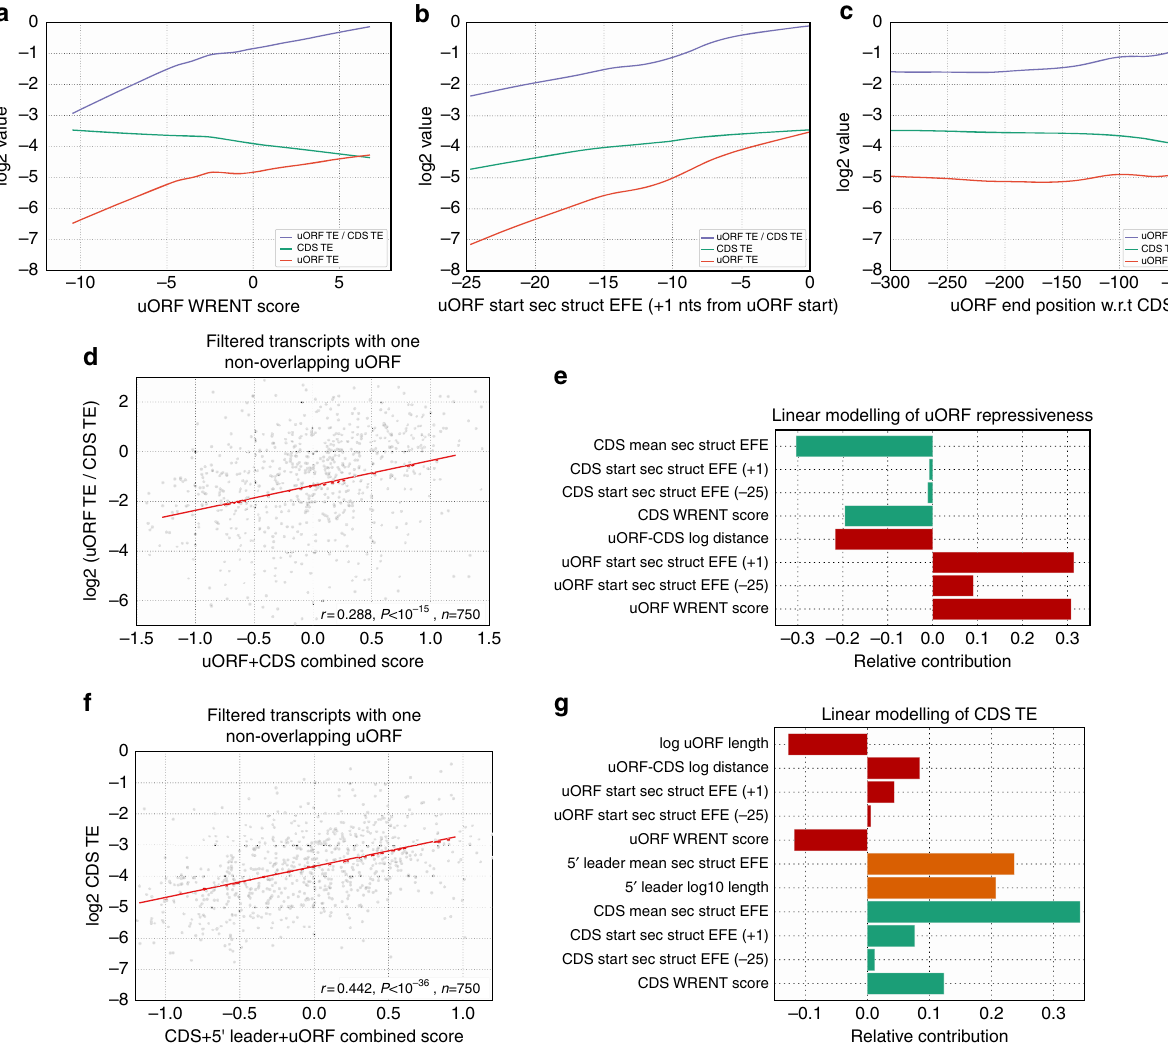
Figure 3 | Modelling of uORF repressiveness and CDS TE with various transcript sequence features. ( a – c ) Relationship between ( a ) uORF initiation context sequence, ( b ) secondary structure and c . uORF-end position w.r.t. (with respect to) CDS against uORF TE (red), CDS TE (green) and uORF TE / CDS TE (blue). uORF repressiveness (estimated from uORF TE / CDS TE) increases with more favourable initiation context sequence ( a ), decreased secondary structure around uORF initiation sites ( b ) and reduced uORF-CDS distance ( c ). All lines are LOWESS fits representing statistically significant rank and linear correlations ( P o 0.05; details in Supplementary Fig. 6) except for uORF TE against uORF-end position w.r.t. CDS ( c ). ( d , e ) Linear modelling of uORF/CDS TE with uORF and CDS sequence features, for transcripts with one non-overlapping uORF. Scatter plot of uORF TE / CDS TE against a combined score that integrates uORF and CDS sequence features; red line indicates the ridge regression linear fit ( d ); relative contributions of individual sequence features to the combined score are depicted in e . ( f , g ) Linear modelling of CDS TE with uORF, 5 0 leader and CDS sequence features, for transcripts with one non-overlapping uORF. Scatter plot of CDS TE is against a combined score that integrates various sequence features; red line indicates the ridge regression linear fit ( f ); relative contributions of individual sequence features to each score are depicted in g